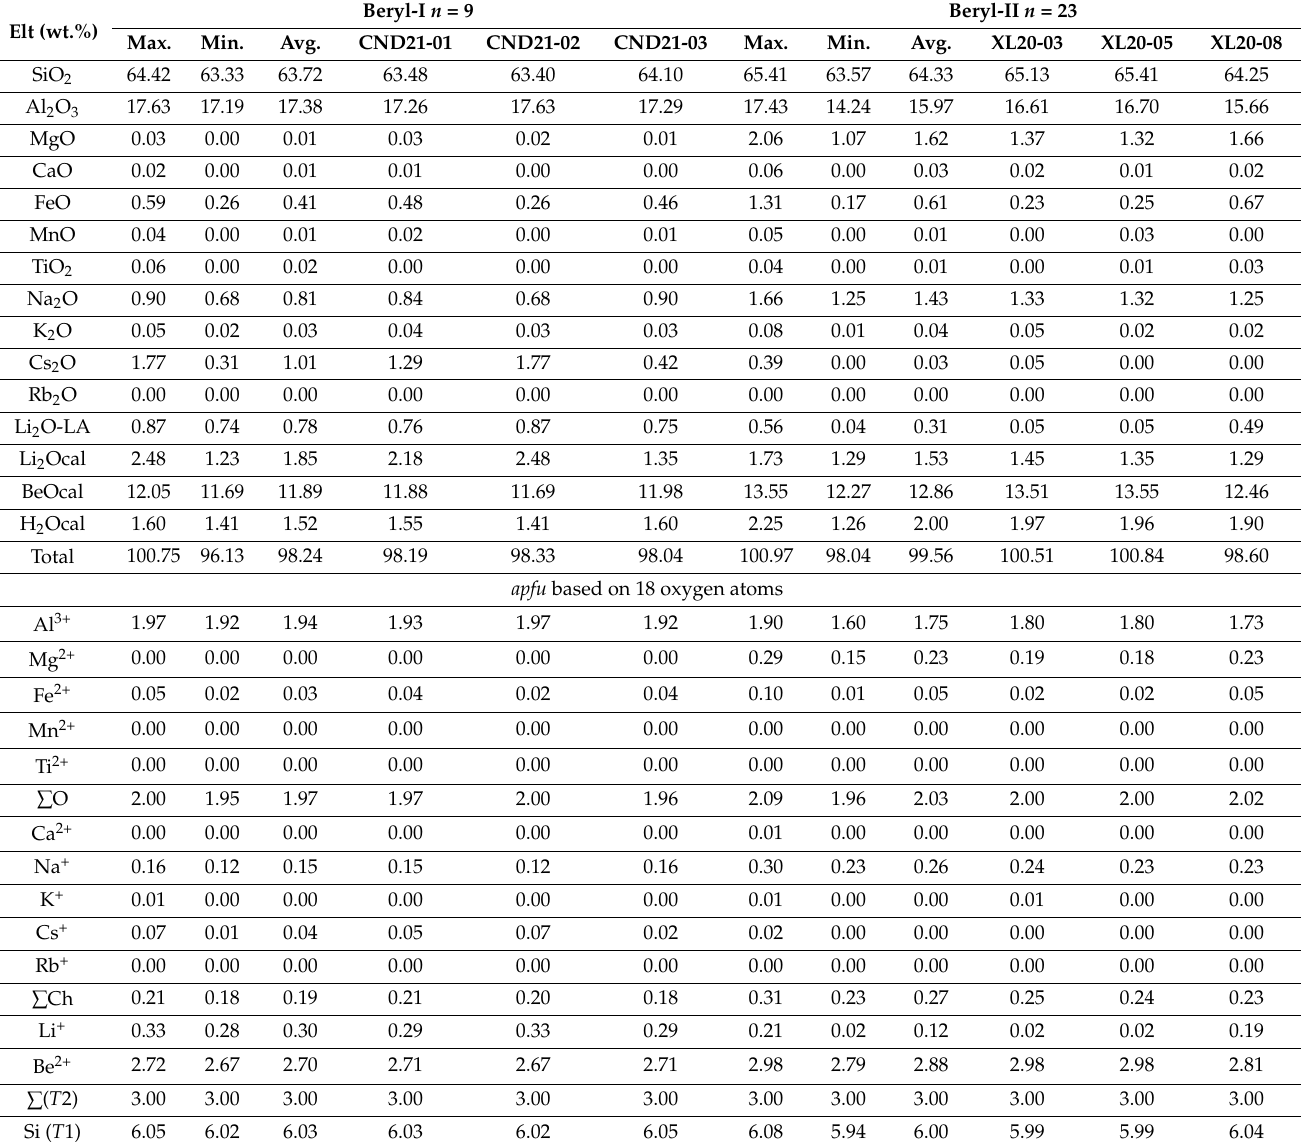
Table 1. Representative electronic microprobe analysis of beryls from the Xianglin area.